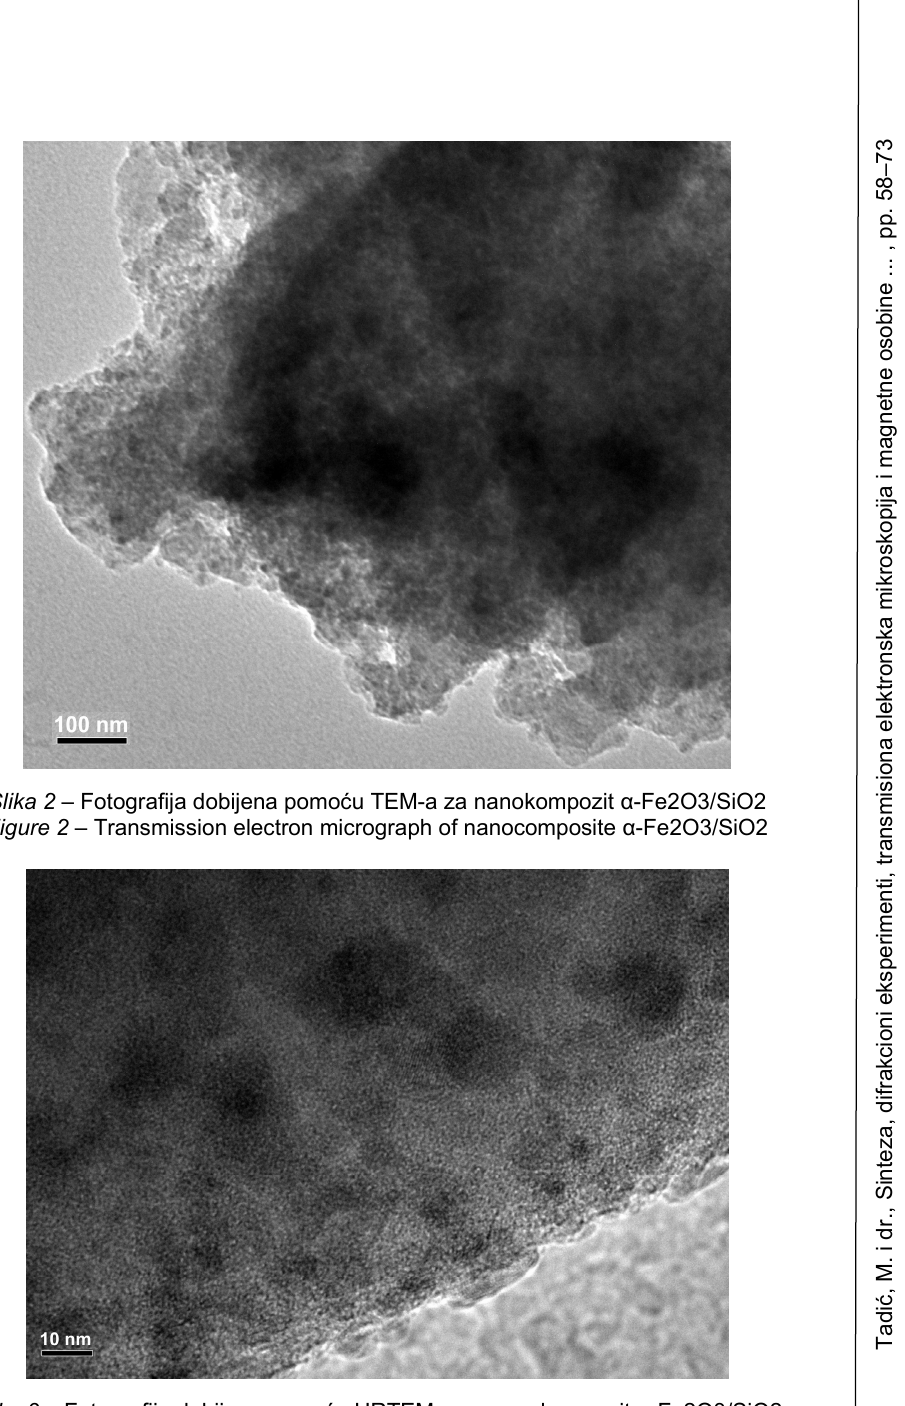
Figure 3 – High resolution transmission electron micrograph of nanocomposite α